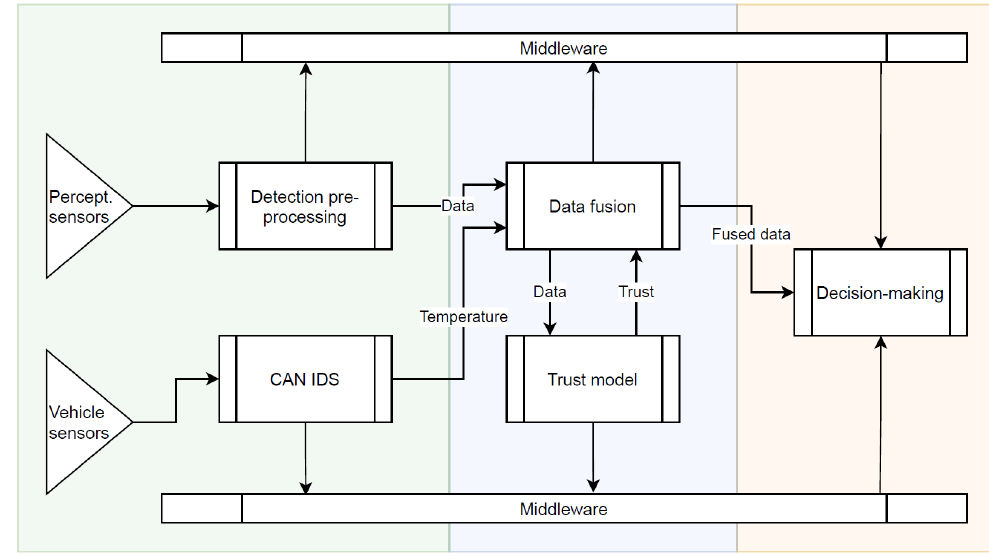
Figure 16. Overall